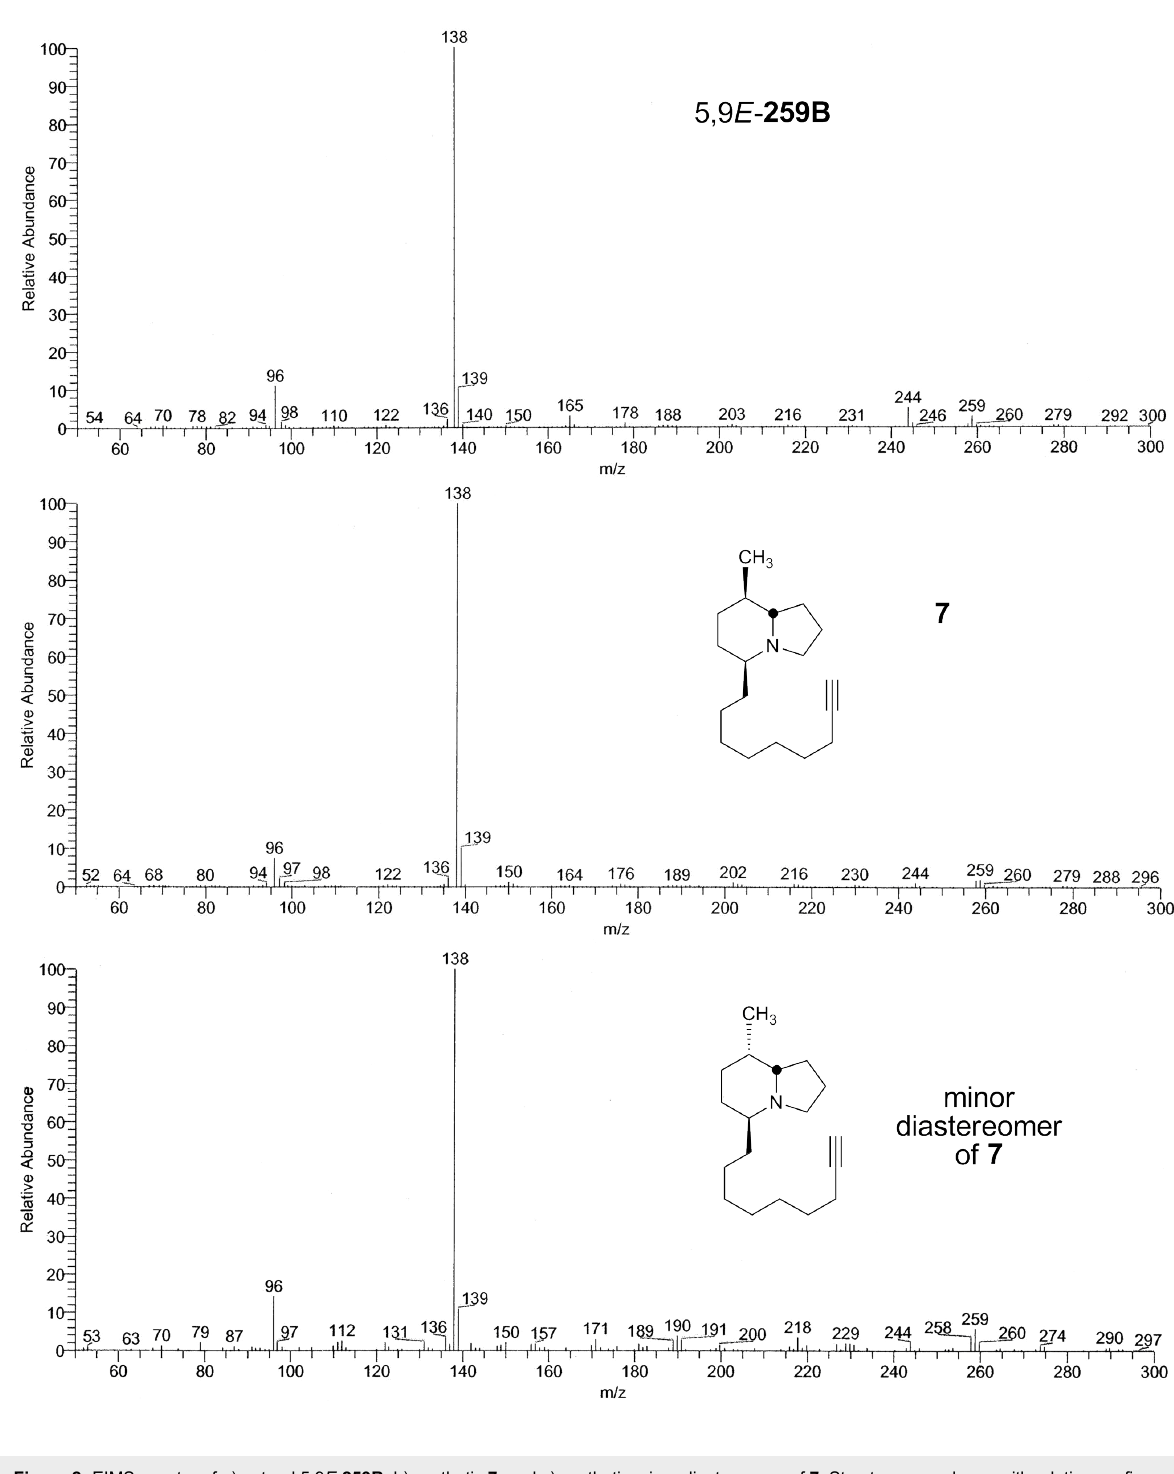
Figure 2: EIMS spectra of a) natural 5,9 E - 259B , b) synthetic 7 , and c) synthetic minor diastereomer of 7 . Structures are shown with relative configur-